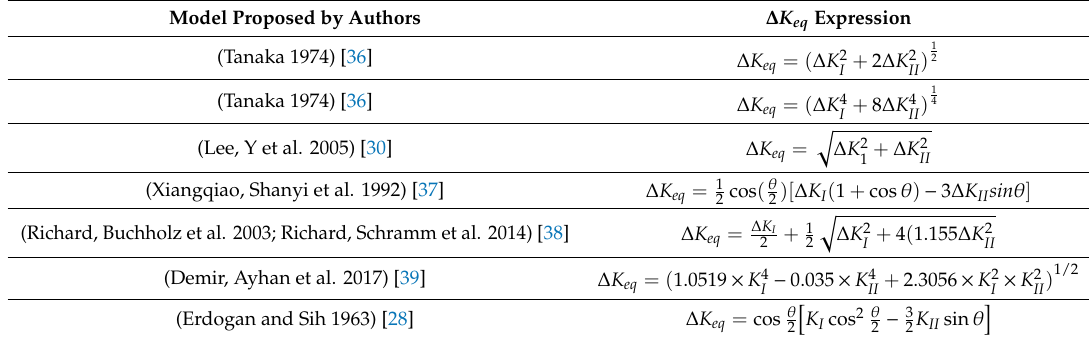
Table 1. Commonly used ∆ K eq